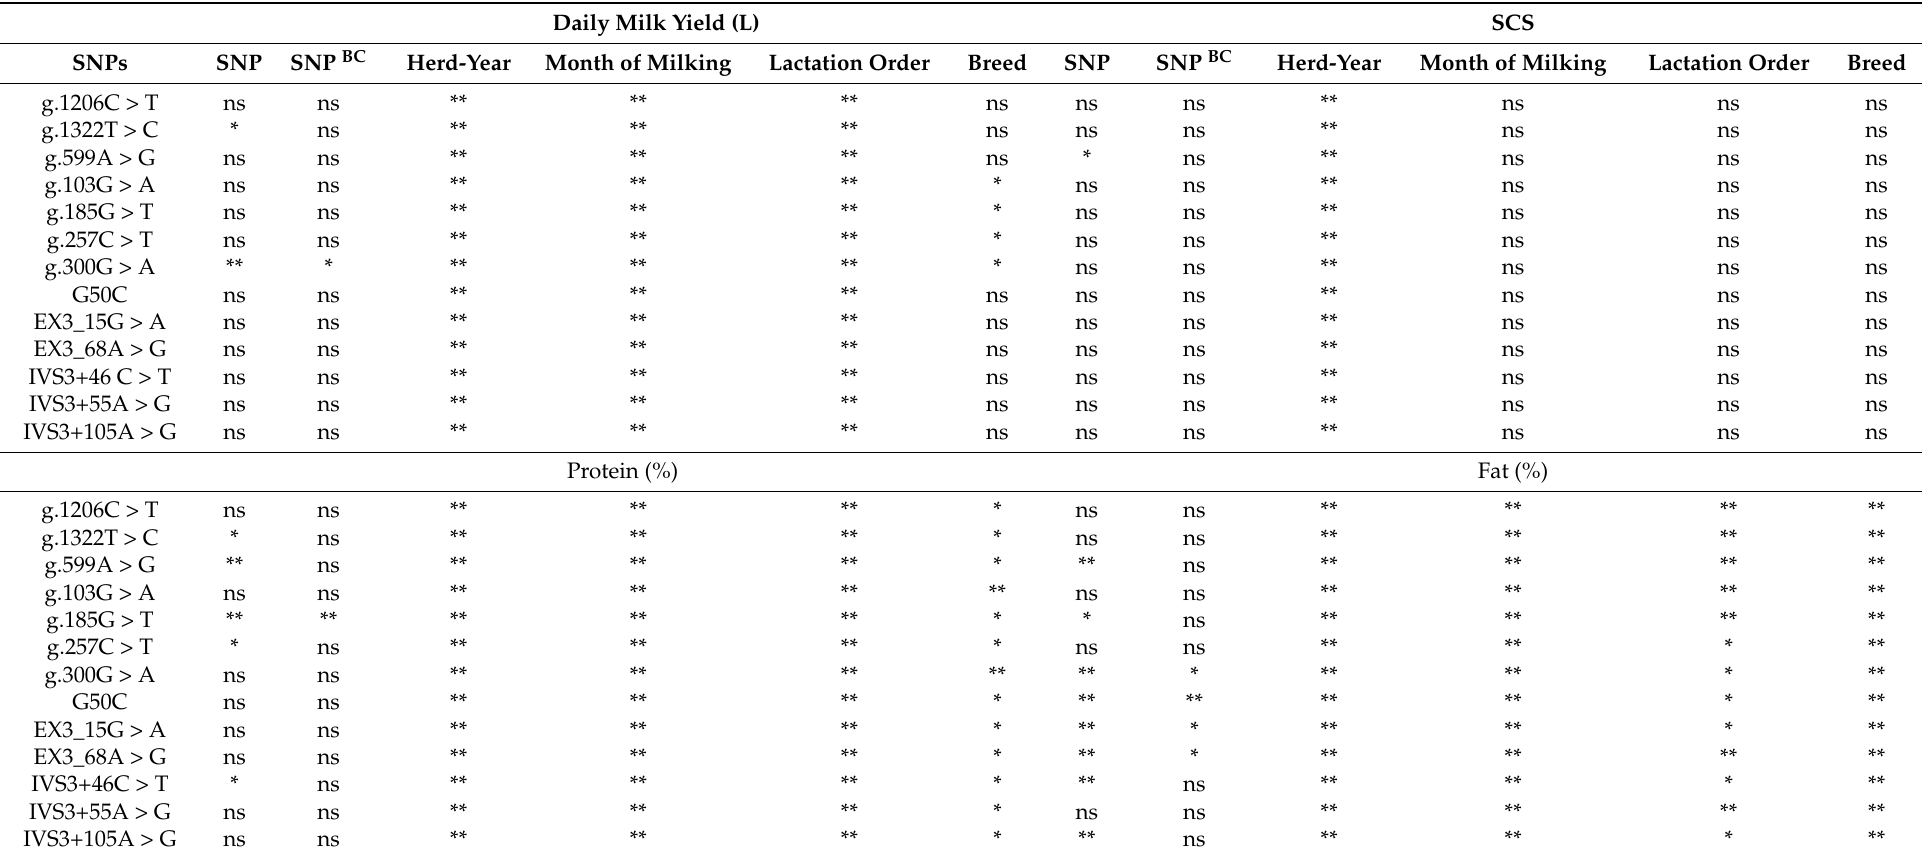
Table 5. Significance of fixed effects for milk traits and somatic cell score—individual